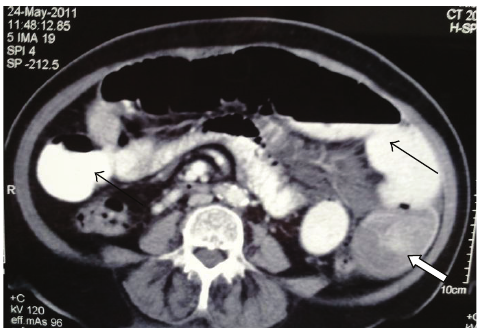
Figure 1: Computed tomography of abdomen showing dilated bowel loops (arrows) and the target sign of intussusception (white